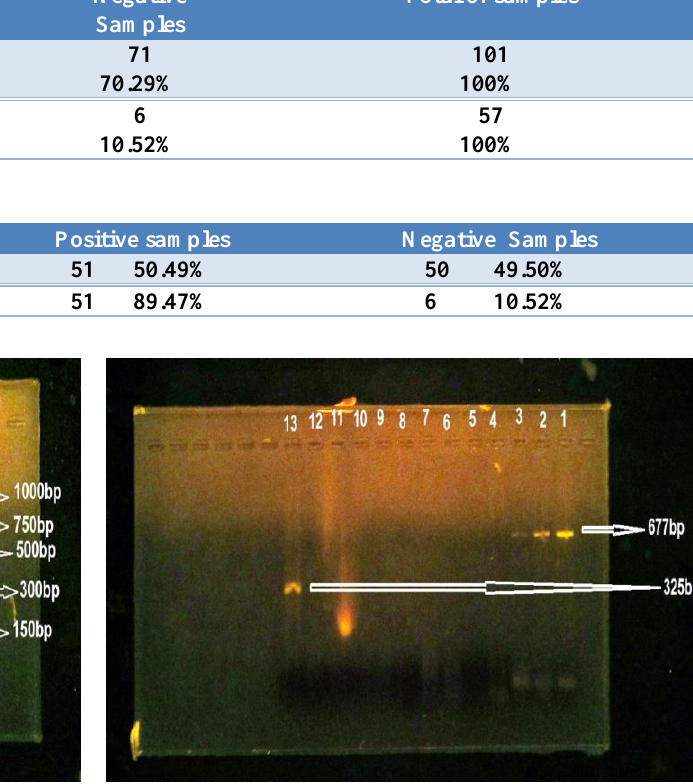
Table , 4: Comparative between the bacterial isolation and PCR test. Test